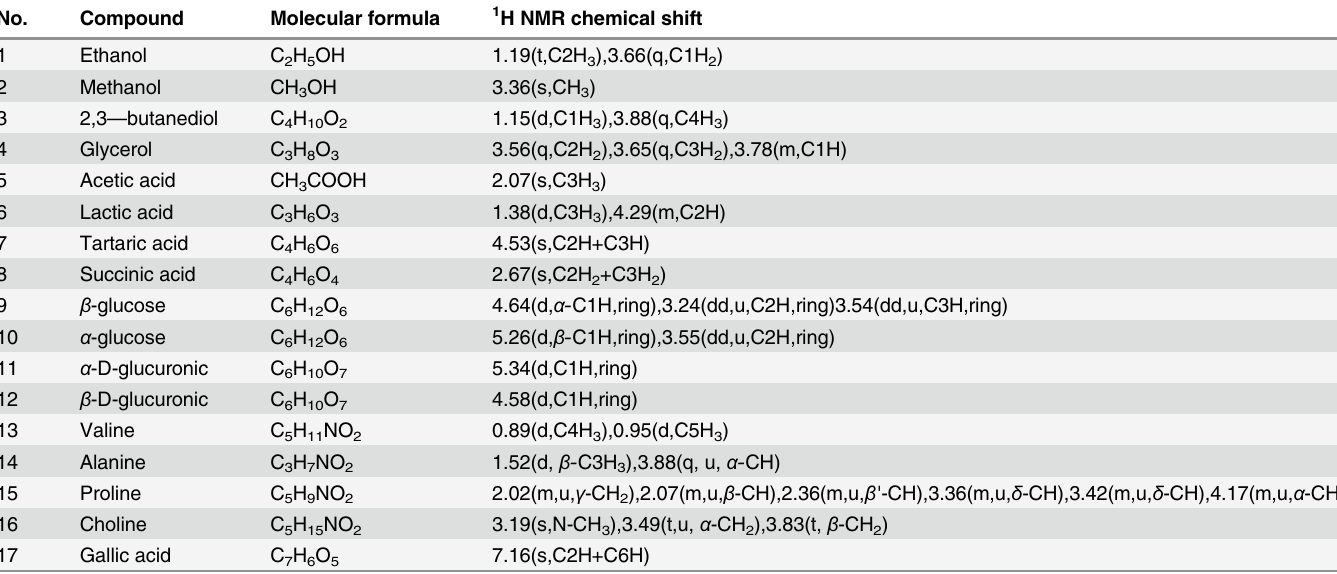
Table 3. Metabolites and their 1 H chemical shifts identified by 600 MHz 1 H NMR *